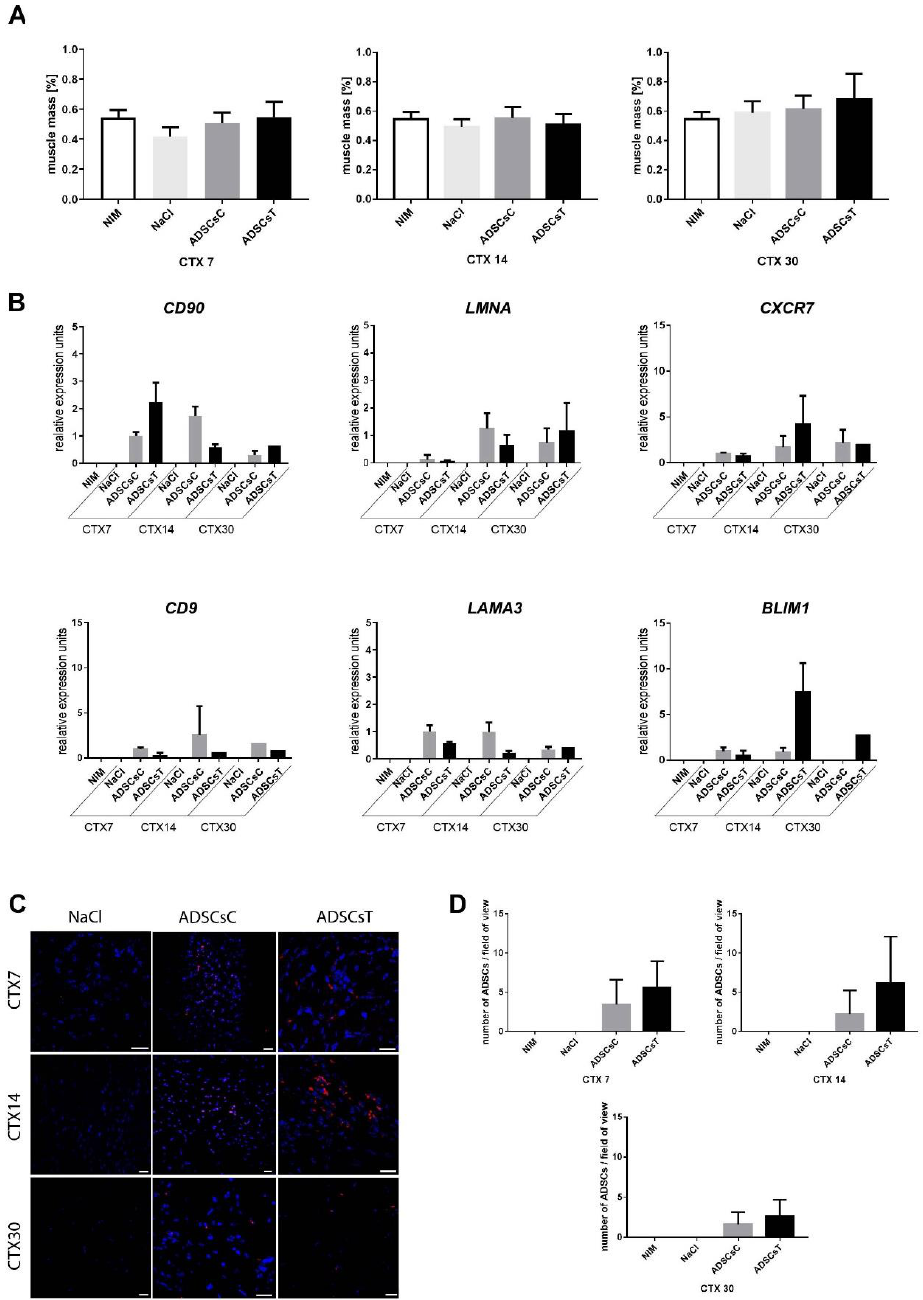
Figure 9. Regeneration of mouse skeletal muscles which received control hADSCs or hADSCs pretreated with IL-4 and SDF-1. ( A ) Weight of non-injured (NIM), injured control (NaCl), control hADSC (ADSCsC), and IL-4 and SDF-1 treated hADSC (ADSCsT) transplanted skeletal muscles related to the weight of the mouse, day 7, 14 and 30 of regeneration. ( B ) Expression of human mRNAs encoding CD90, LMNA, CXCR7, CD9, LAMA3, and BLIM1 in control and regenerating mouse muscles. Expression was normalized to mRNA encoding HPRT. ( C ) Localization of hADSCs within the skeletal muscle at day 7, 14, and 30 of regeneration using visualization of human nuclei (red) and all nuclei (blue), bar = 20 µm. ( D ) Number of hADSCs per field of view in injured control and ADSC transplanted skeletal muscles at day 7, 14, and 30 of regeneration. CTX7 - day 7; CTX14 - day 14; CTX30 - day 30 of regeneration, For each experimental group n ≥ 3. Data are presented as mean ± SD. Data have been analyzed using Kruskal-Wallis